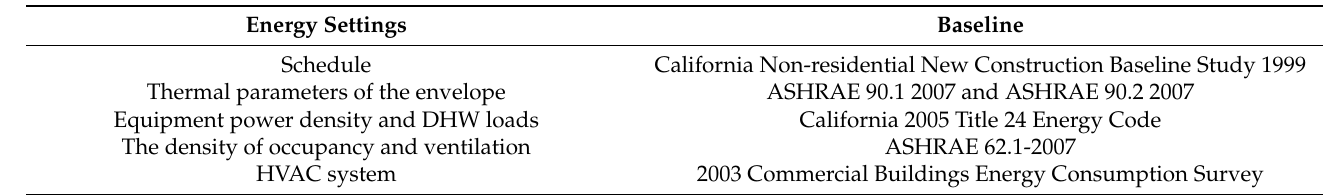
Table 5. Summary of building energy